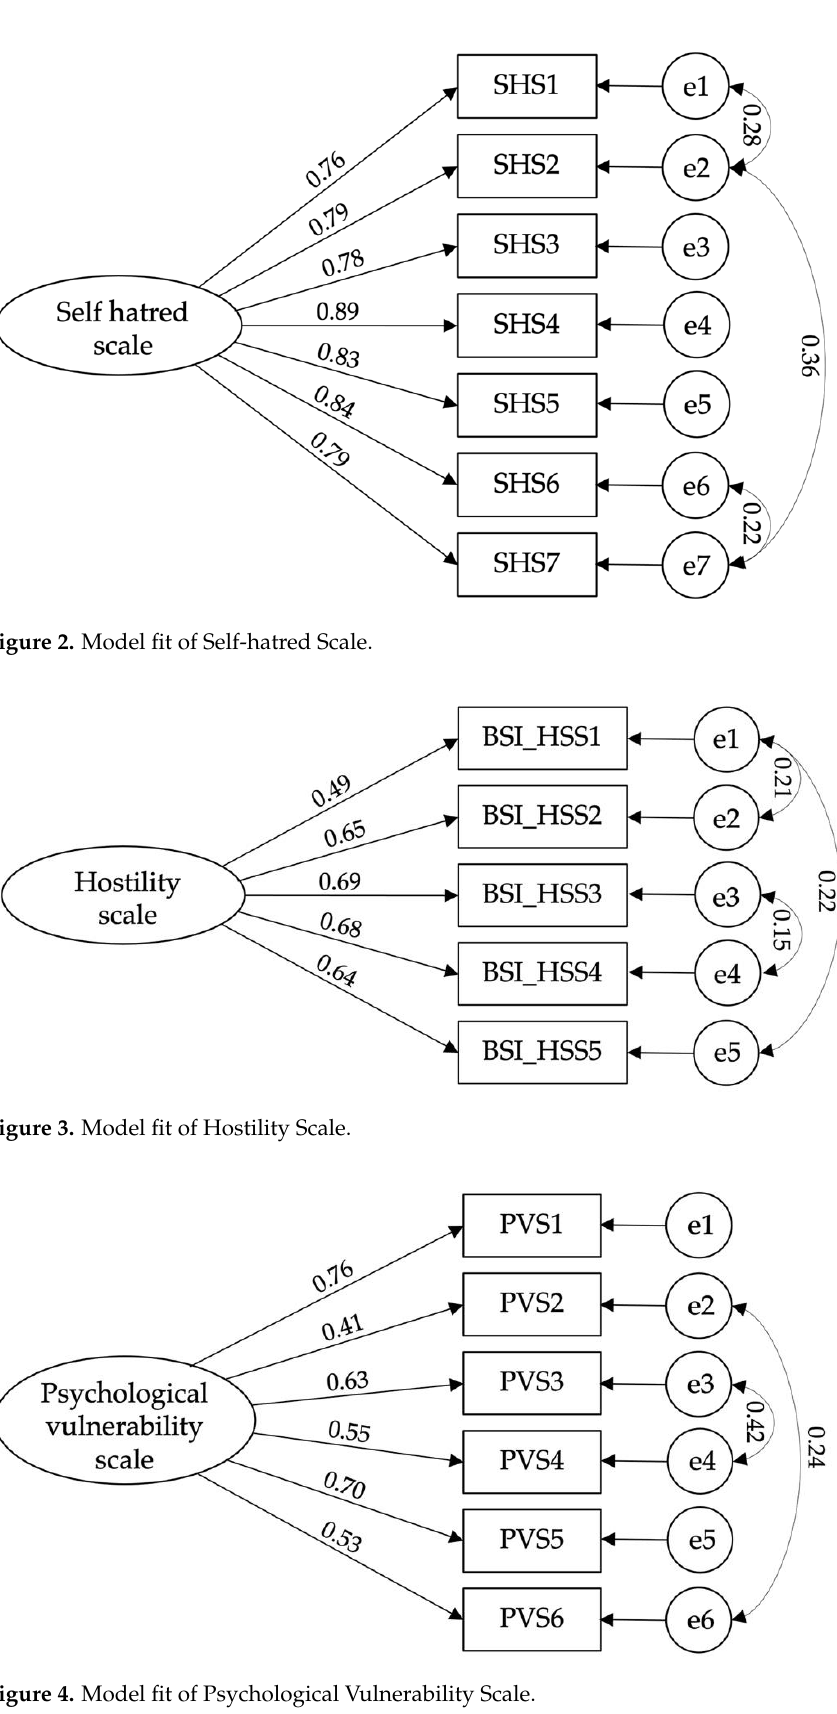
Figure 4. Model fit of Psychological Vulnerability